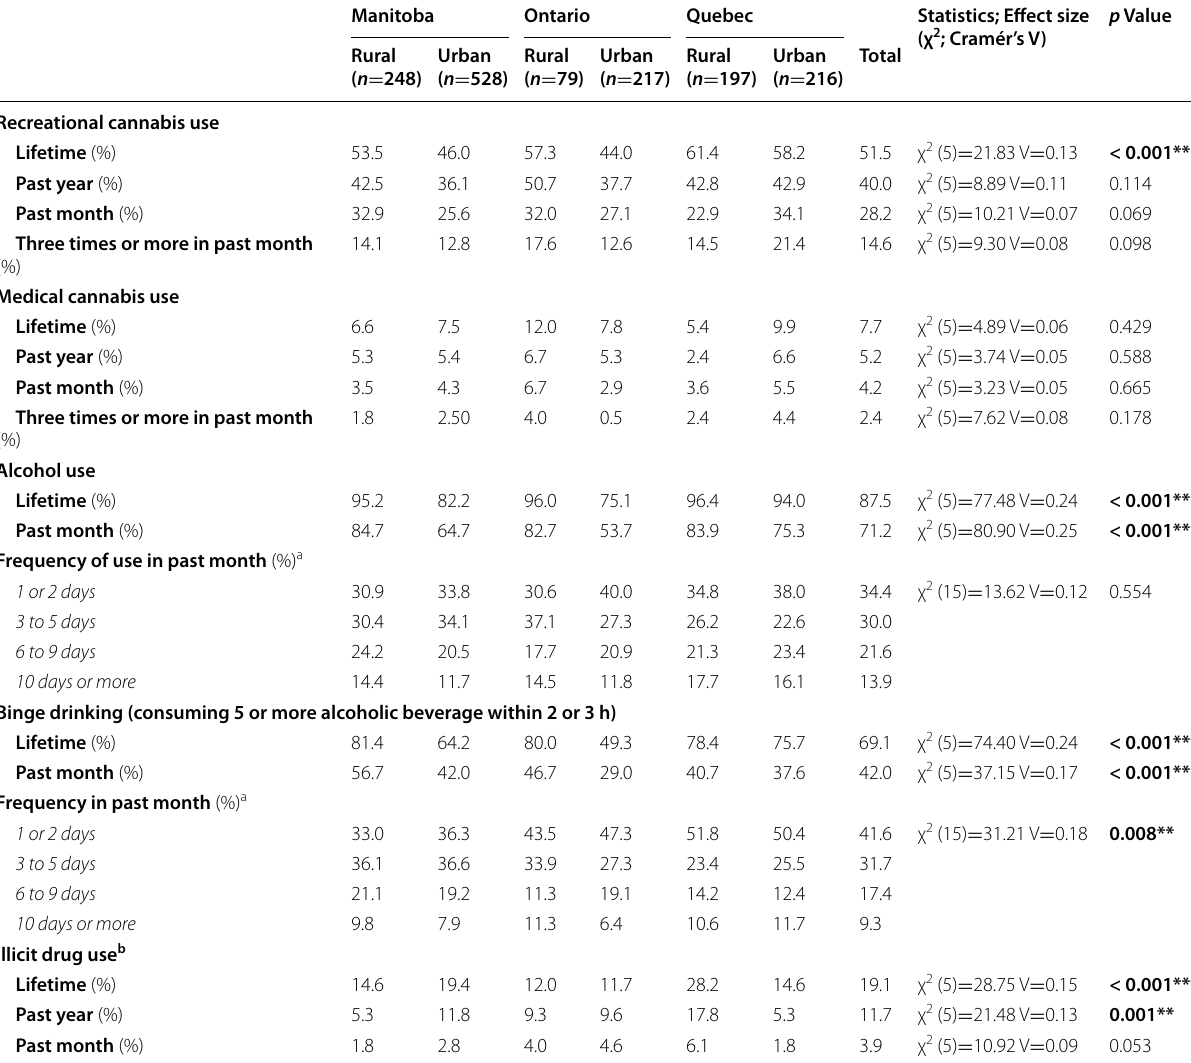
Table 2 Prevalence of recreational cannabis, alcohol, tobacco, and illicit drug use. by province and rural/urban